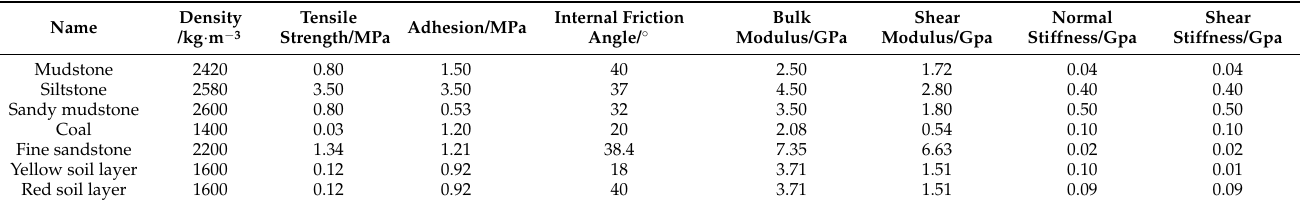
Table 2. Numerical model parameters.